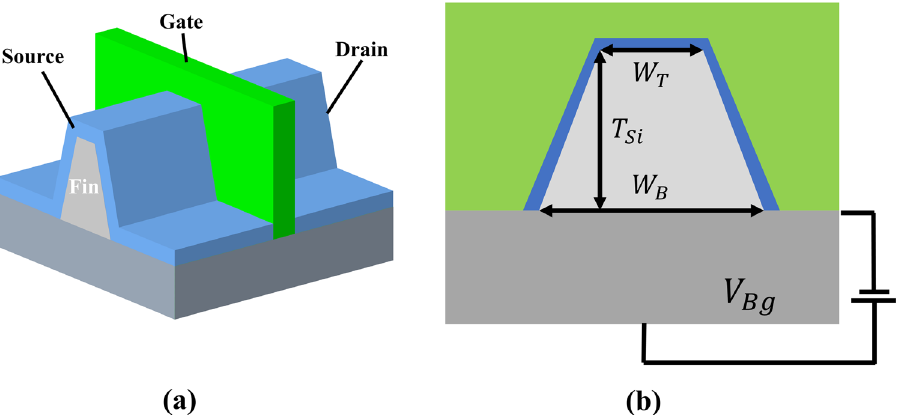
Figure 5. ( a ) 3D outline schematic of FinFET device; ( b ) 2D cross-sectional schematic of channel of FinFET device channel. Green, blue, light gray, and dark gray regions represent the gate, silicon oxide, silicon channel, and oxide box of the device, respectively. The figures were drawn with the Creo 7 educational version provided by PTC (www. ptc.